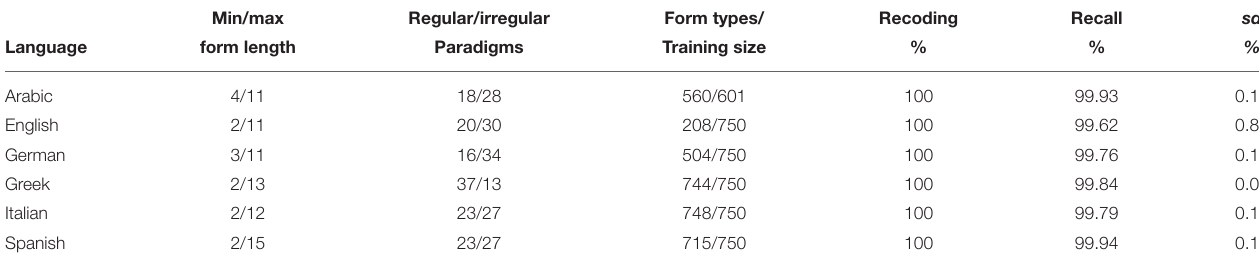
TABLE 1 | Statistics for the 6 datasets.